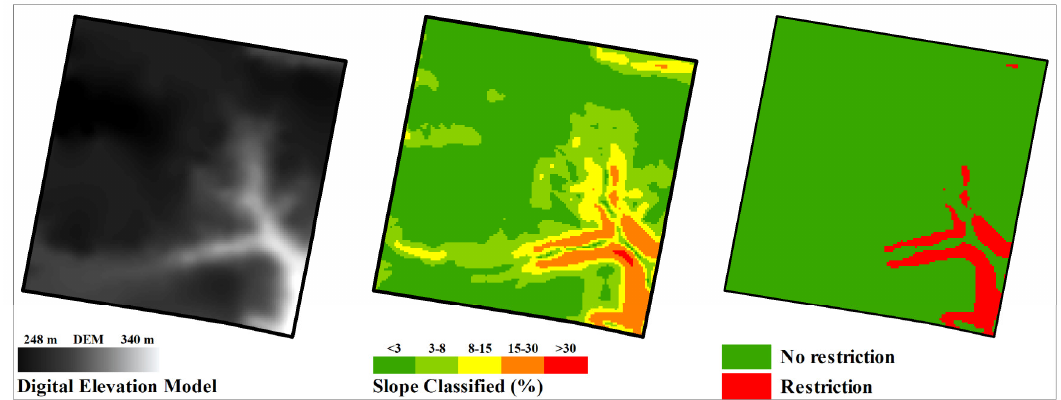
Figure 3. Digital elevation model, slope classification and slope restriction of areas suitable for yards’ allocation.